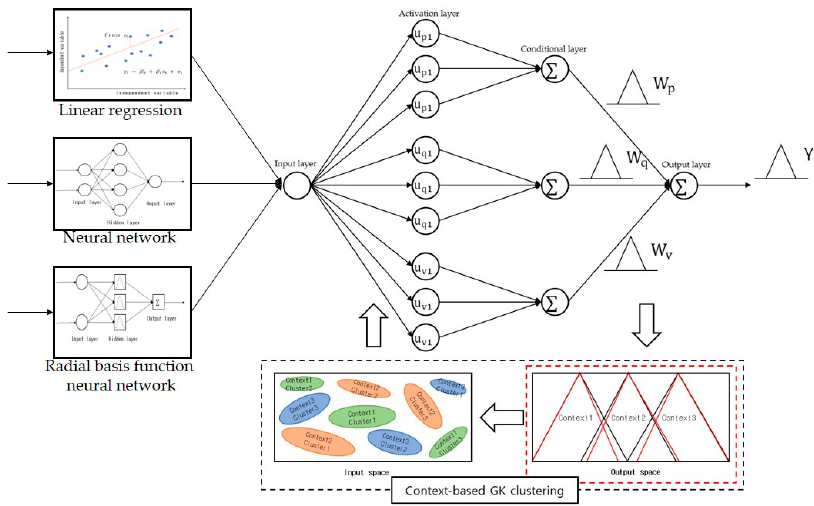
Figure 8. Structure of the optimized CGK-based fuzzy granular model of the aggregated